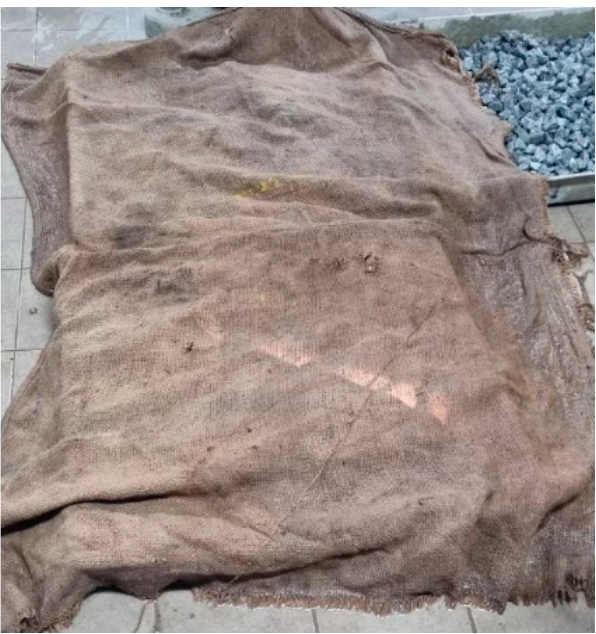
Figure 2. Typical sackcloth. Table 2. Details of mix components